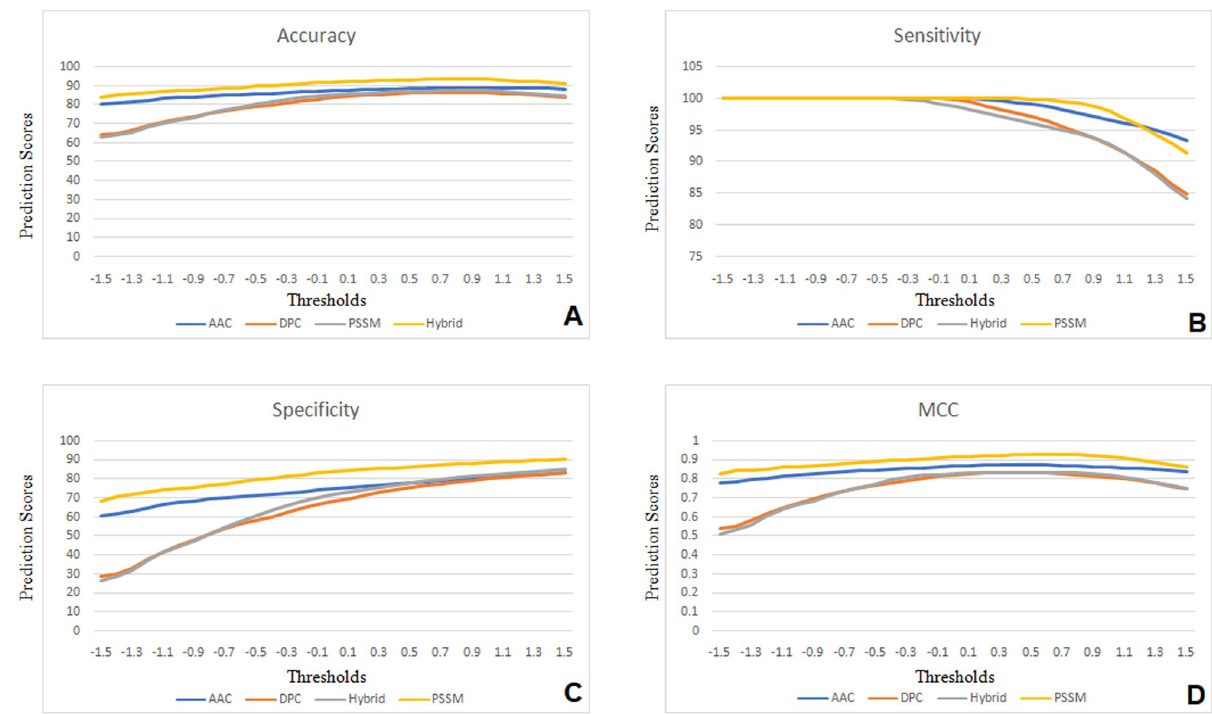
Fig 3. The performance of accuracy (A), sensitivity (B), specificity (C) and MCC (D) based on the threshold value in all